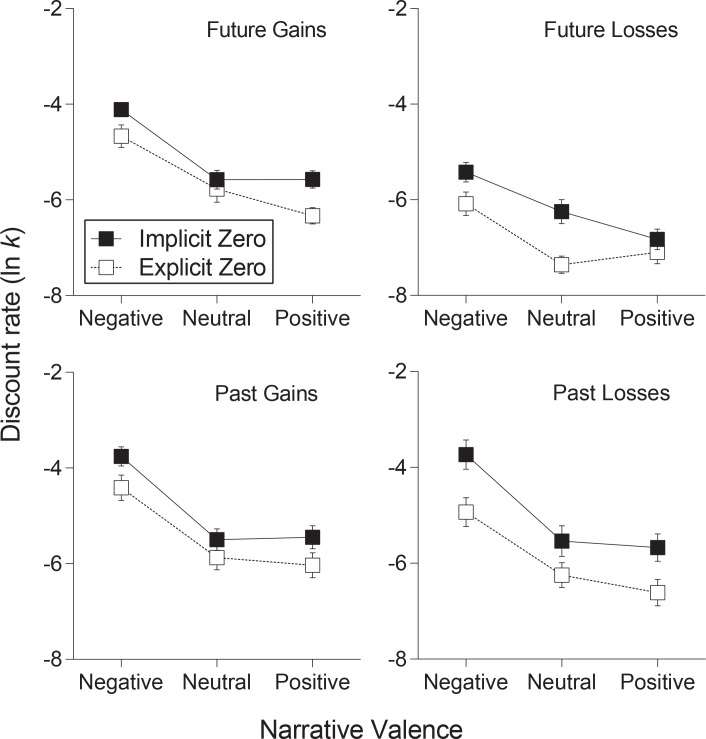
Mean discount rate in response to narrative valence for future.Gains (top left), future losses (top right), past gains (bottom left), and past losses (bottom right). Data are stratified by implicit-/explicit-zero framing. Error bars represent standard error of the mean.